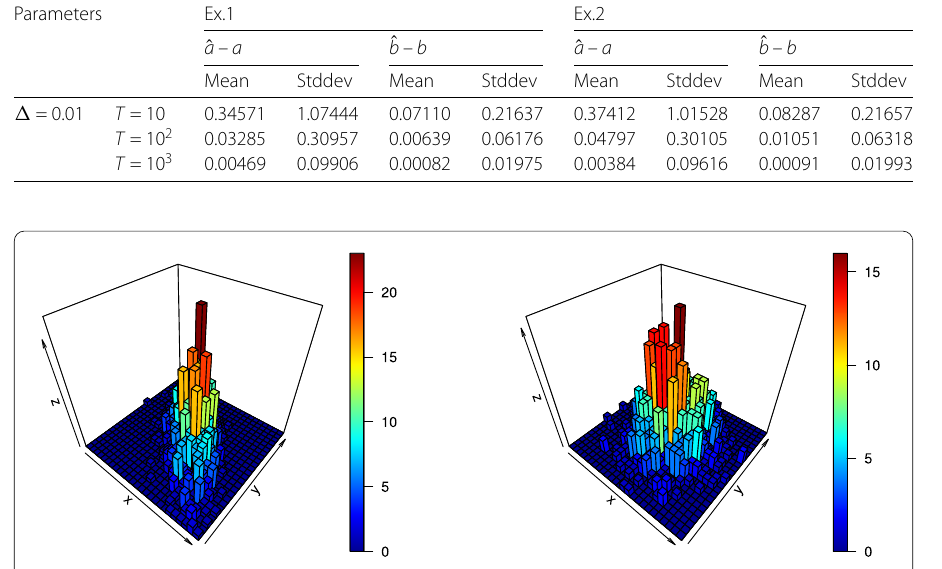
Figure 3 (Left) 3D histogram of 1000 Monte Carlo simulations of β T of Example 5.1 with a = 1, b = 7, σ = 1, r = 1, T = 10, and (cid:7) = 0.01 and x 0 = 10. (Right) The 3D histogram of 1000 random vectors from 2-dimensional standard normal